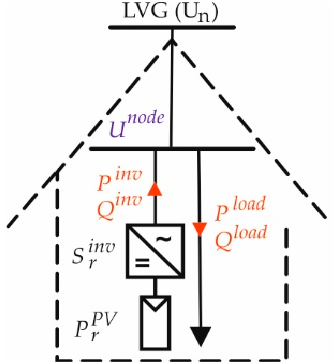
Figure 3. Structure of each prosumer.